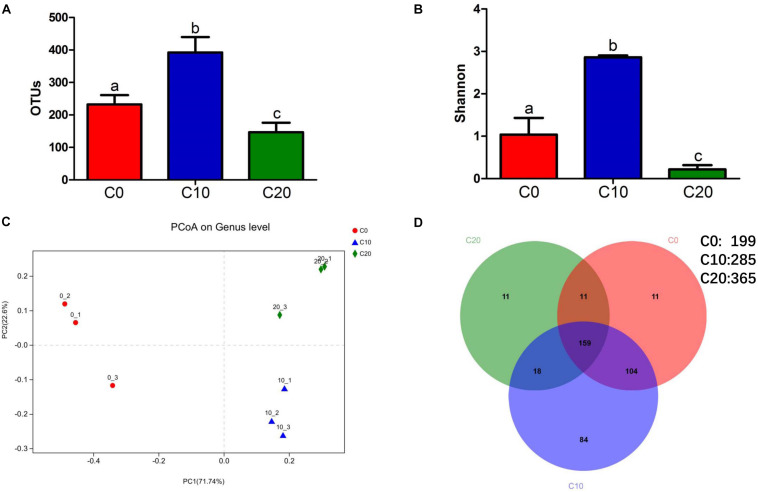
Diversity of gut microbial community. (A) Operational taxonomic unit levels; (B) Shannon’s diversity indices; (C) principal coordinate analysis of weighted UniFrac analysis; (D) Venn diagram shows the numbers of shared and unique core genera in the gut microbiota of C0 group, C10 group, and C20 group. To evaluate the numbers of unique and shared genera, core microbiota which were present in all the samples in each group were computed. Mothur v.1.30.1 was used to identify the unique and shared genera in the different study groups. C0, non-challenge control; C10, 10% gelatinized starch-challenged group; C20, 20% gelatinized starch-challenged group. Data are presented as the means ± SEMs (n = 3). Different lowercase letters above the bars indicate significant difference (P < 0.05).